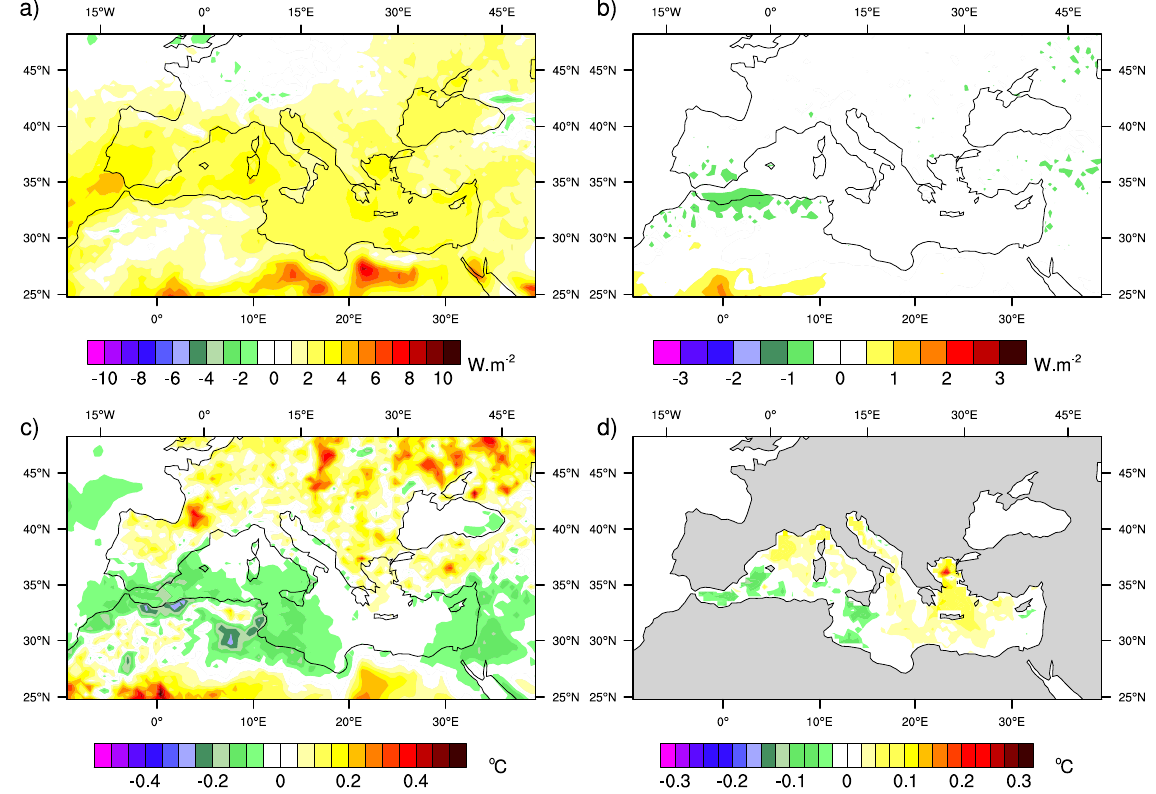
Figure 13. Average difference in summer 2012 between the PROG and PROG-M simulations in terms of (a) SW surface direct radiative forcing (Wm − 2 ), (b) LW surface direct radiative forcing (Wm − 2 ), (c) 2m temperature ( ◦ C) and (d) sea surface temperature ( ◦ C).